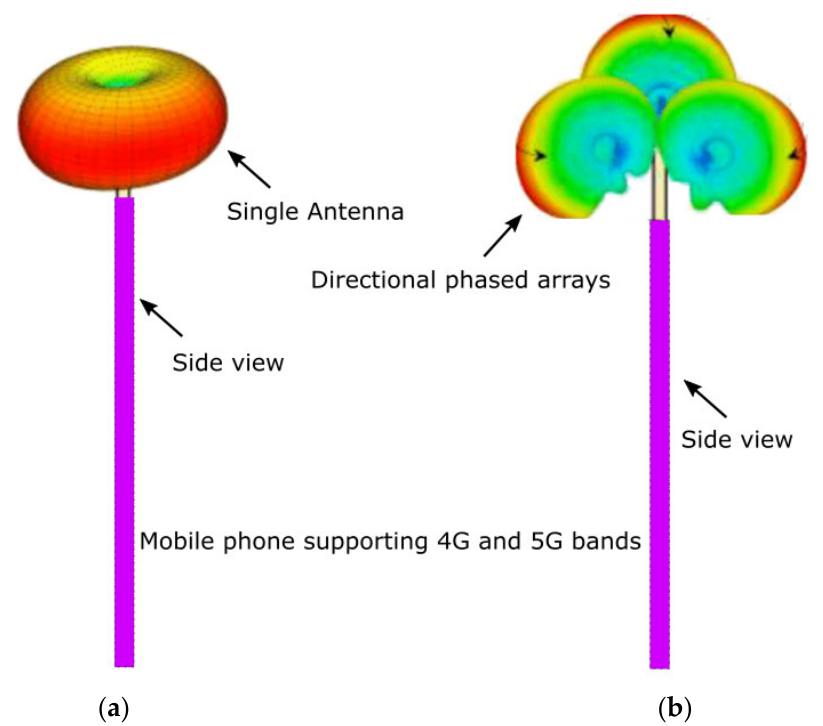
Figure 7. Proposed radiation pattern of mobile phone; ( a ) 4G and ( b ) 5G, concept taken from [13].